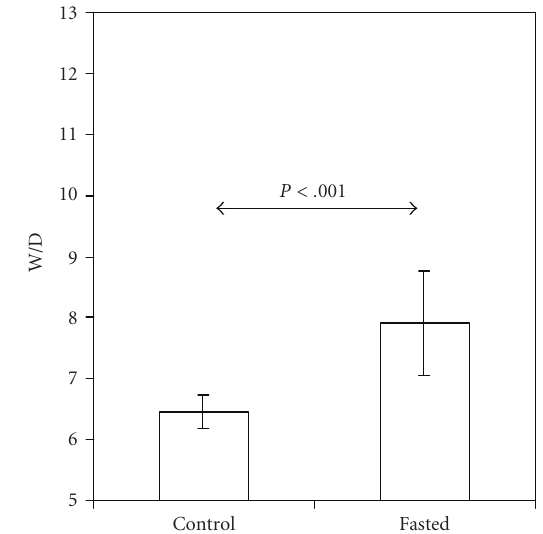
Figure 7: Skin water content (W/D) is higher in 1-day-old term rat pups at the end of an 18-h period of fasting (fasted; n = 19) than in suckling controls ( n = 18). Values are presented as mean ±